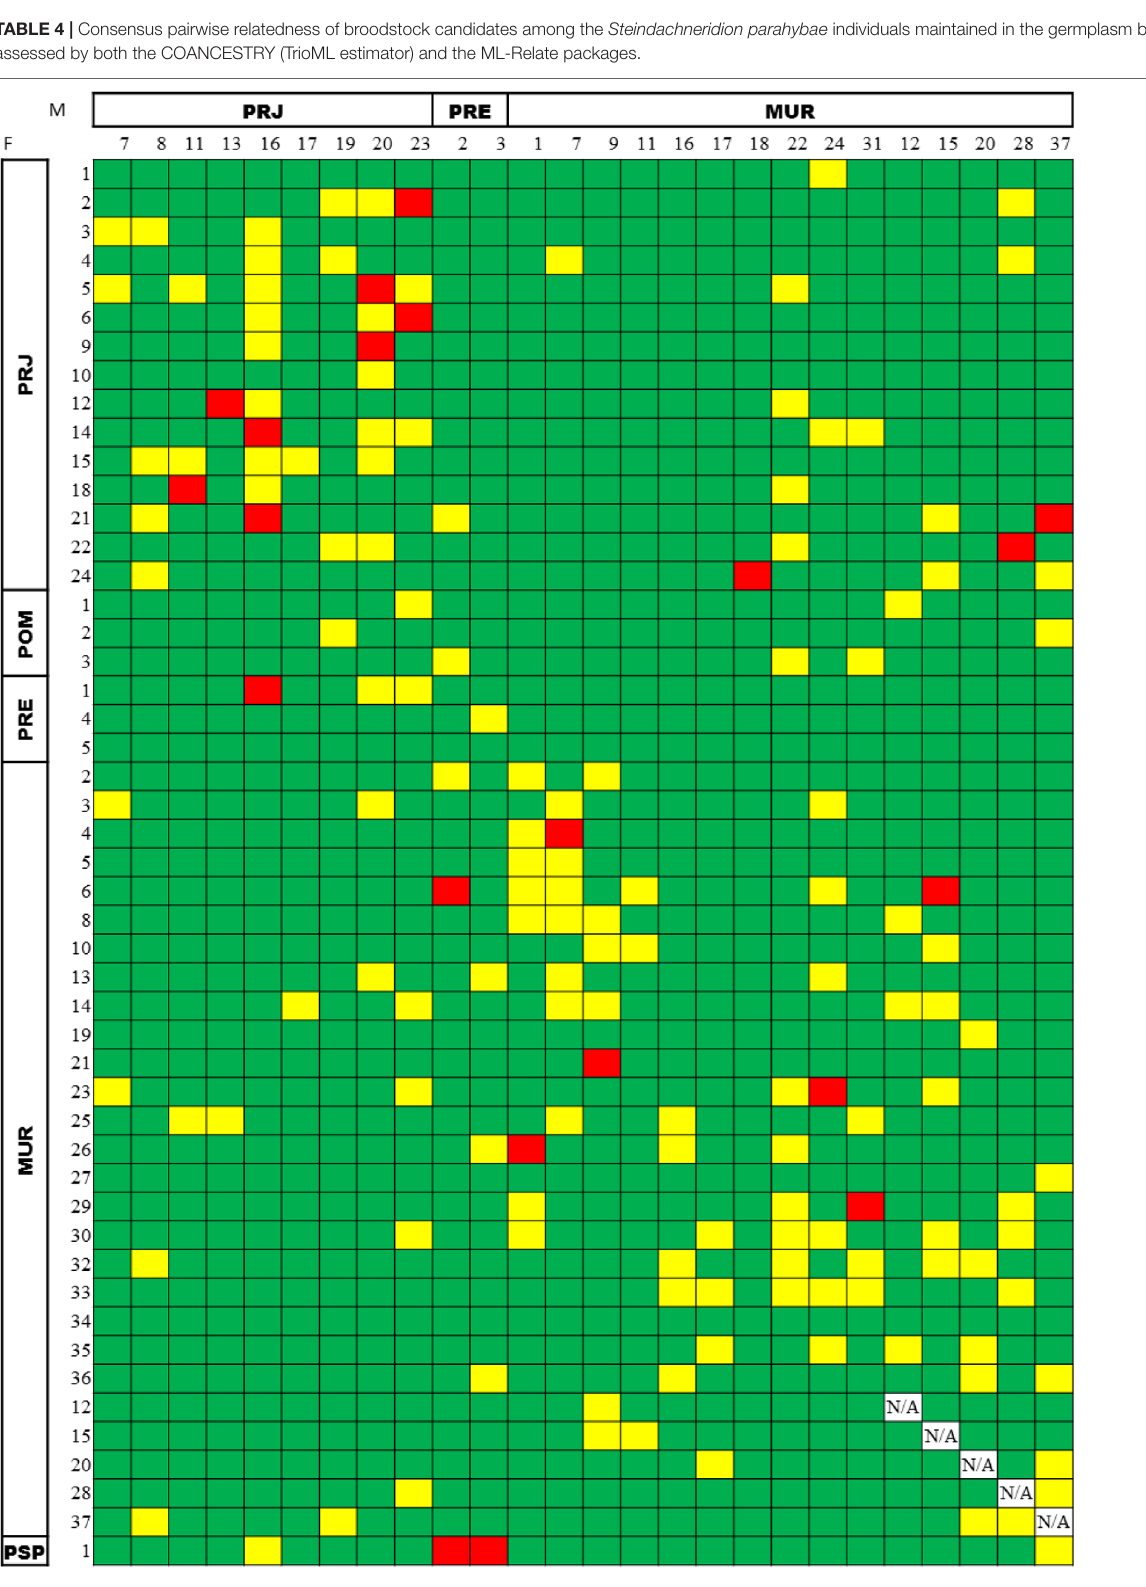
Crosses in red and yellow cells should be avoided due to high or moderate level of kinship. Shown in green cells are the consensus best crosses for producing offspring for restocking due to low kinship. Females are denoted (F) and males (M). N/A – data not available, for individuals of indeterminate sex.